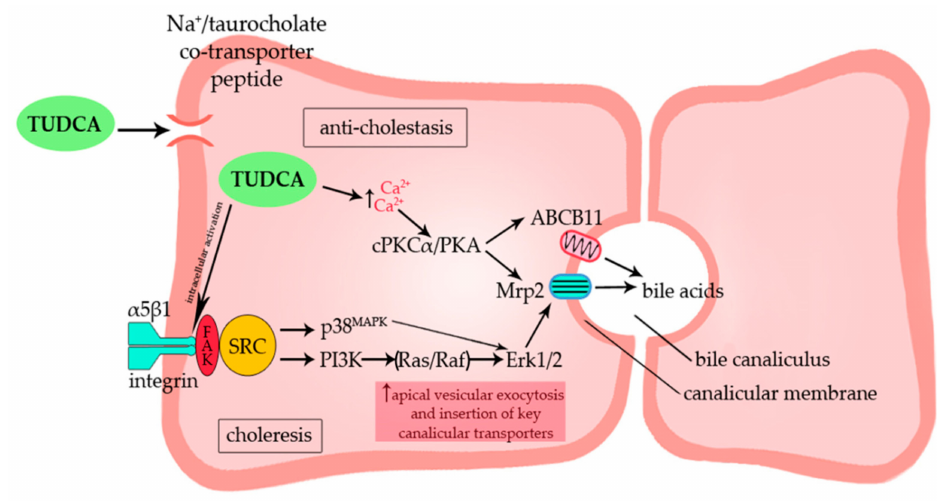
Figure 3. Schematic presentation of cellular e ff ects and molecular signaling pathways initiated by TUDCA in cholestatic hepatocytes. Hepatoprotective e ff ects are attributable to the TUDCA-mediated activation of two main signaling pathways: Ca 2 + -dependent signaling pathway and α 5 β 1 integrin-dependent signaling pathway. Stimulation with TUDCA